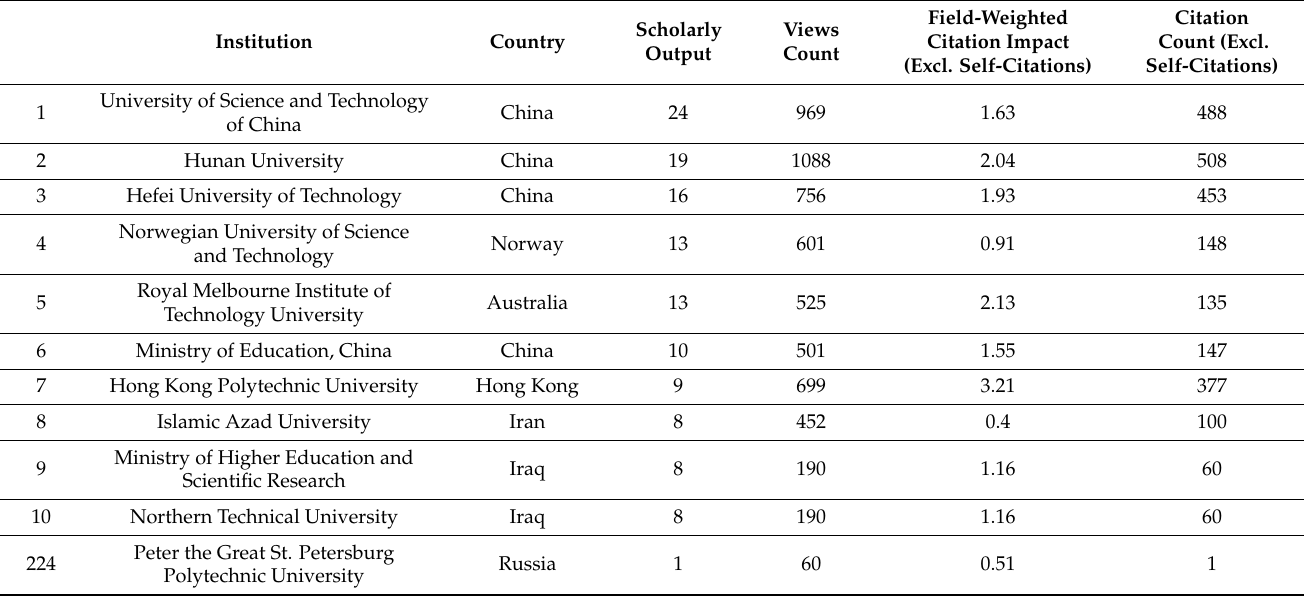
Table 4. Top Institutions (accessed on 21 January